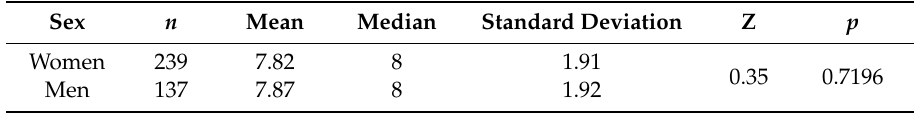
Table 5. The level of intensity of the motivation to undertake PA due to cheering in the 6th Poznan Half Marathon—depending on sex. Sex n